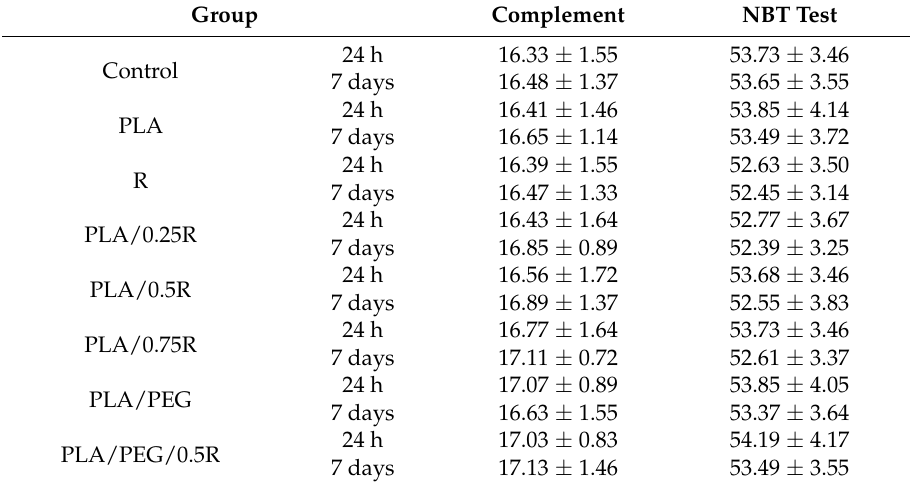
Table 15. The effects of PLA-based materials containing rosemary ethanolic extract on the serum complement activity and the NBT test. Values were expressed as mean ± S.D. for six rats in a